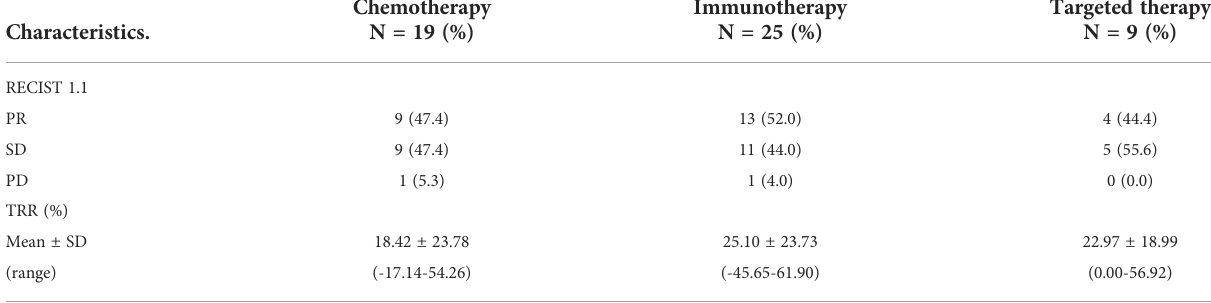
Chemotherapy Immunotherapy Targeted therapy Characteristics.